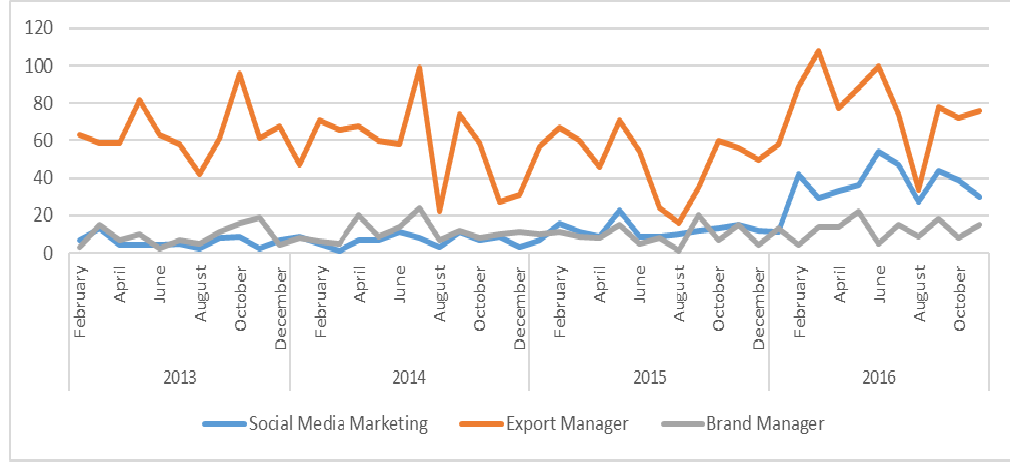
Figure 7: Number of Vacancies by Month and by New Potential